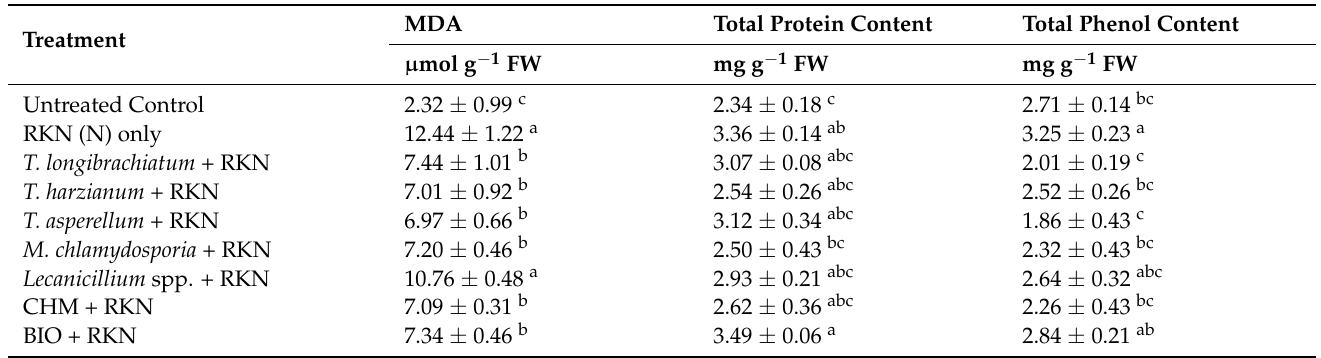
Table 4. Effect of filamentous fungi soil treatment on phenol, lipid peroxidation (MDA), and protein contents on tomato roots 7 days after M. javanica